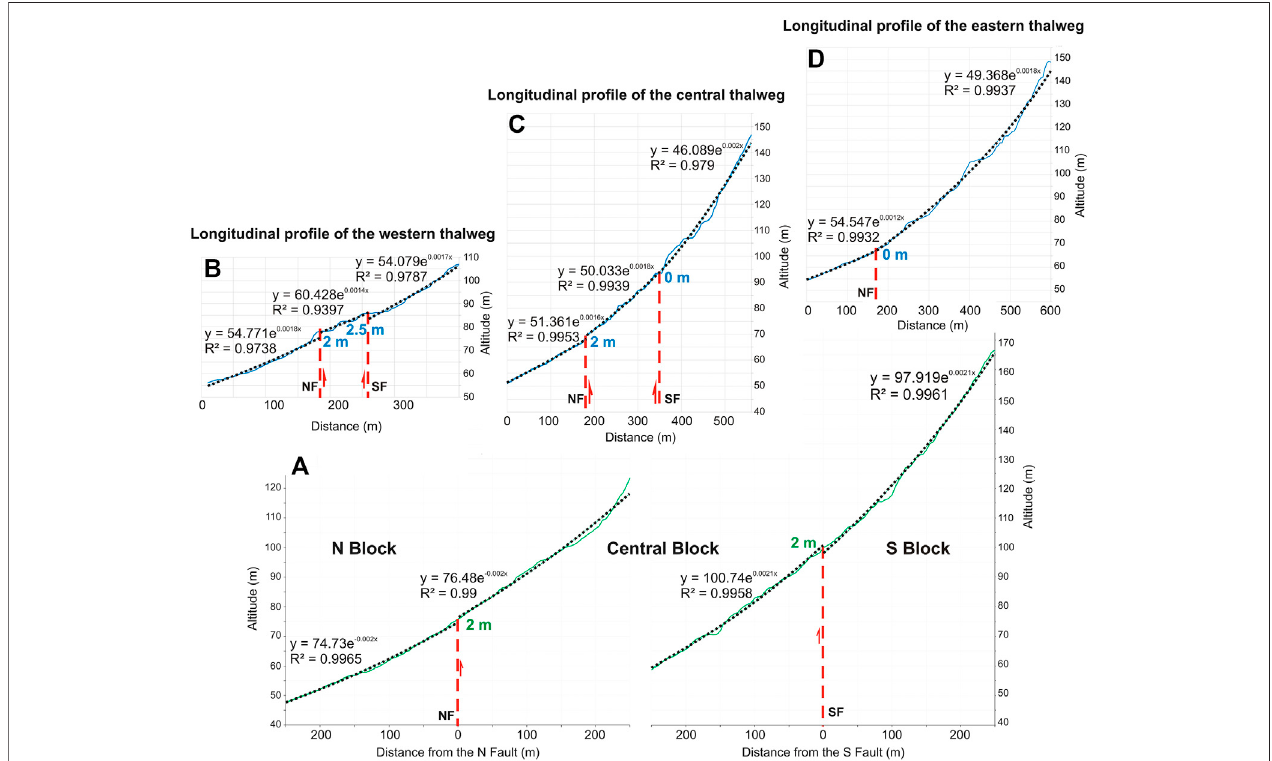
FIGURE 6 | (A) : Topographic pro fi le of the mode value (swath pro fi les perpendicular to the traces of the faults). The dashed lines represent the trend lines (exponentialregressionwithitscorrespondingfunctionandconstant)ofthepro fi leonbothsideofthefaults. (B) , (C) and (D) :Topographicpro fi lesoftheminimumvalues (swath pro fi les longitudinal to the western, central and eastern thalwegs, respectively). The dashed line is the trend lines (exponential regression with its corresponding function and constant) of the pro fi le on both side faults. Altitude measured in m. a. s